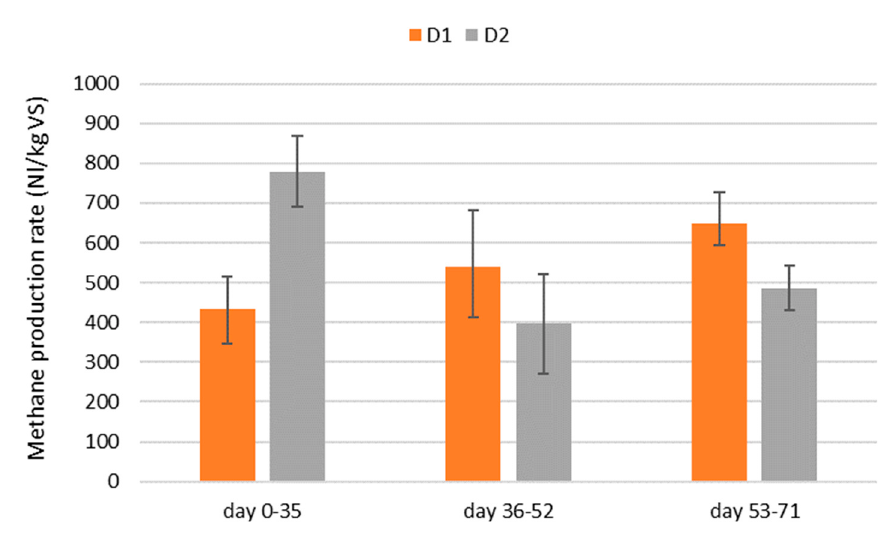
Figure 5. Methane production rates from the 2 digesters during the 3 trial phases.